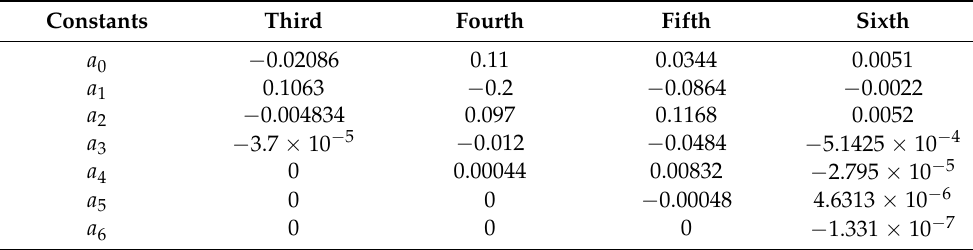
Table 1. Constants of the power coefficients found in relation to the order of the general polynomial function.